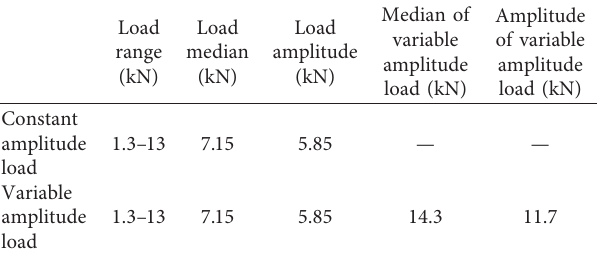
Figure 5: Schematic diagram of three-hole plate Table 1: Table of fatigue load test parameters.